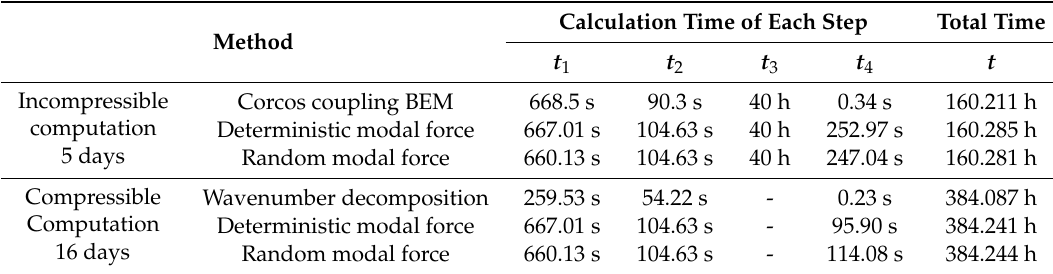
Table 3. Computational time comparison of each